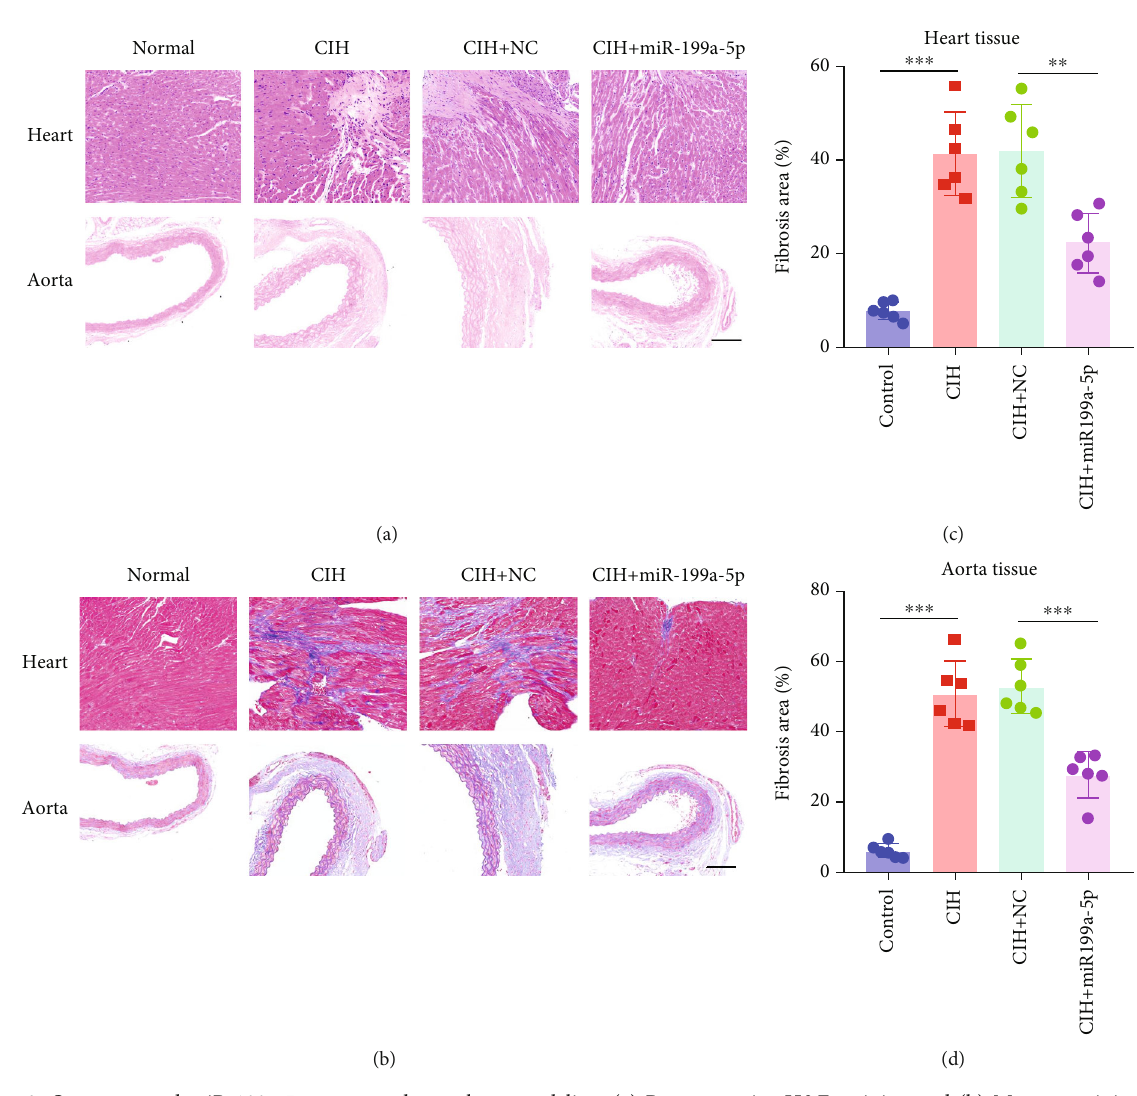
Figure 3: Overexpressed miR-199a-5p attenuated vascular remodeling. (a) Representative H&E staining and (b) Masson staining in the heart and abdominal aorta of rats in control, CIH, CIH+NC, and CIH+miR-199a-5p groups. Scale bar = 25 μ m . The fi brosis area of Masson staining in the (c) heart and (d) abdominal aorta. The collagen deposition was stained in blue. CIH: chronic intermittent hypoxia; NC: negative control. ∗∗ P < 0 : 01 , ∗∗∗ P < 0 : 001 . n = 6 per